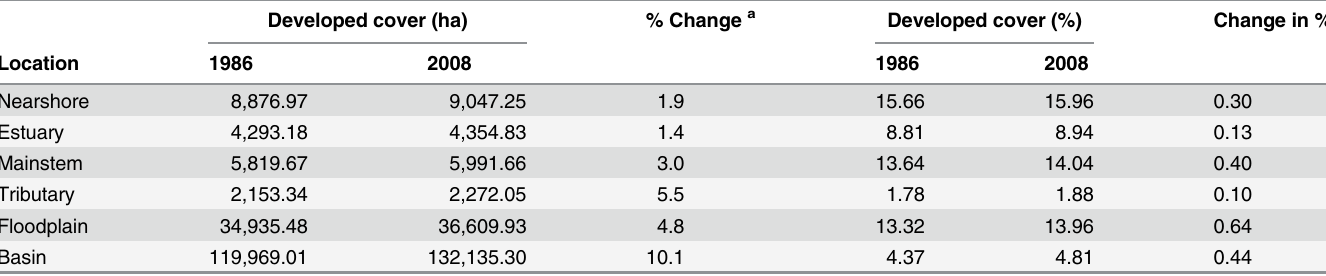
Table 1. Developed Land Cover in 1986 and 2008: Puget Sound